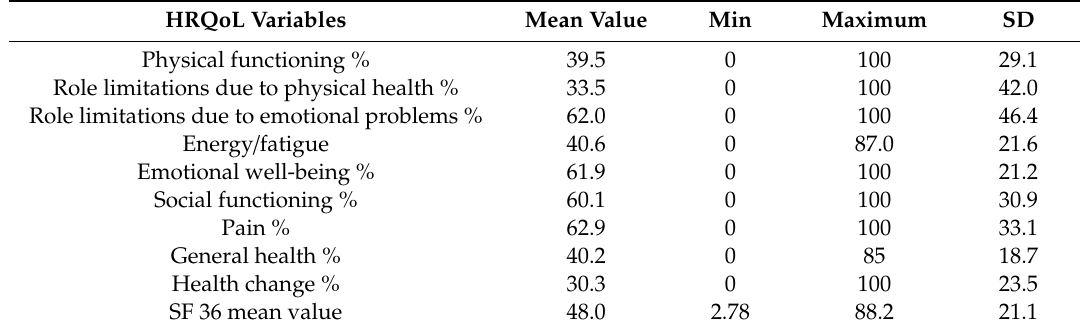
Table 3. Results of health-related quality of life (HRQoL) analysis in uILD cohort.